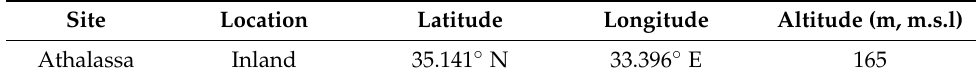
Table 1. Site parameters for the Athalassa meteorological station.